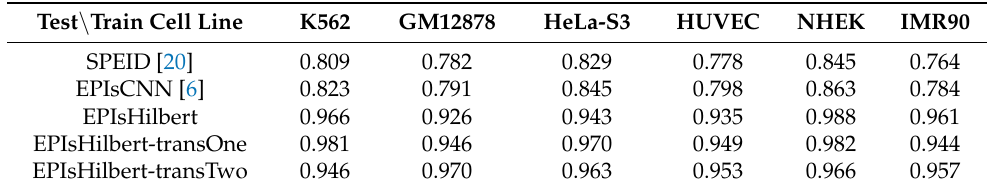
Table 8. The comparison of AUPR value in different methods. Test\Train Cell Line